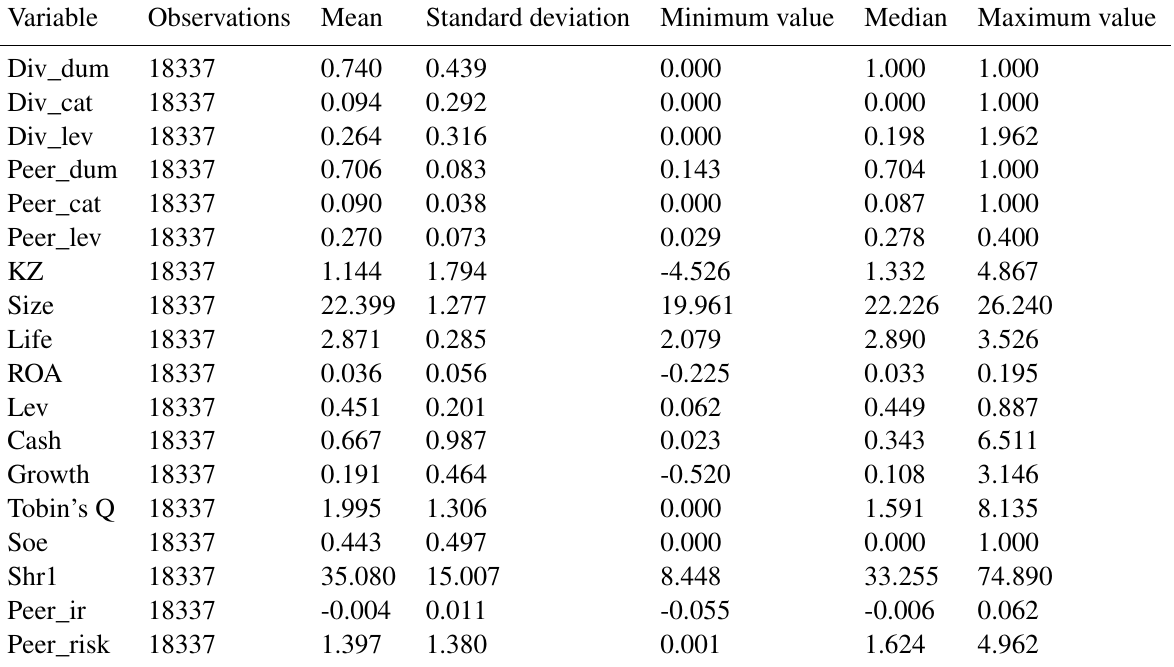
Table 3 Descriptive statistics of major variables.